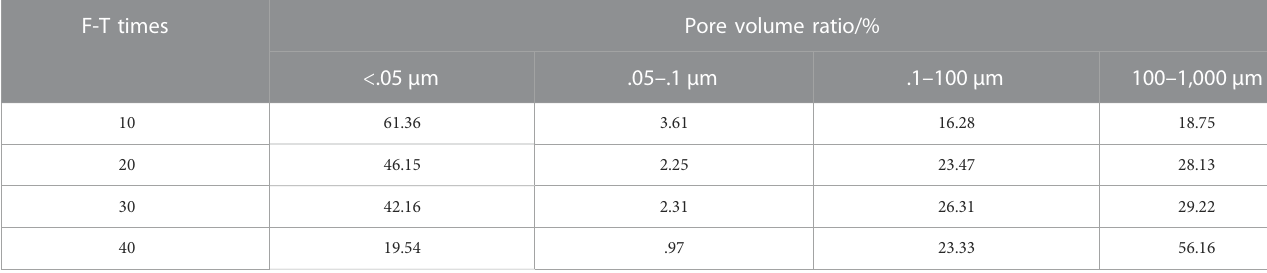
TABLE 1 Determination of pore size distribution after different freeze-thaw times by MIP test. F-T times